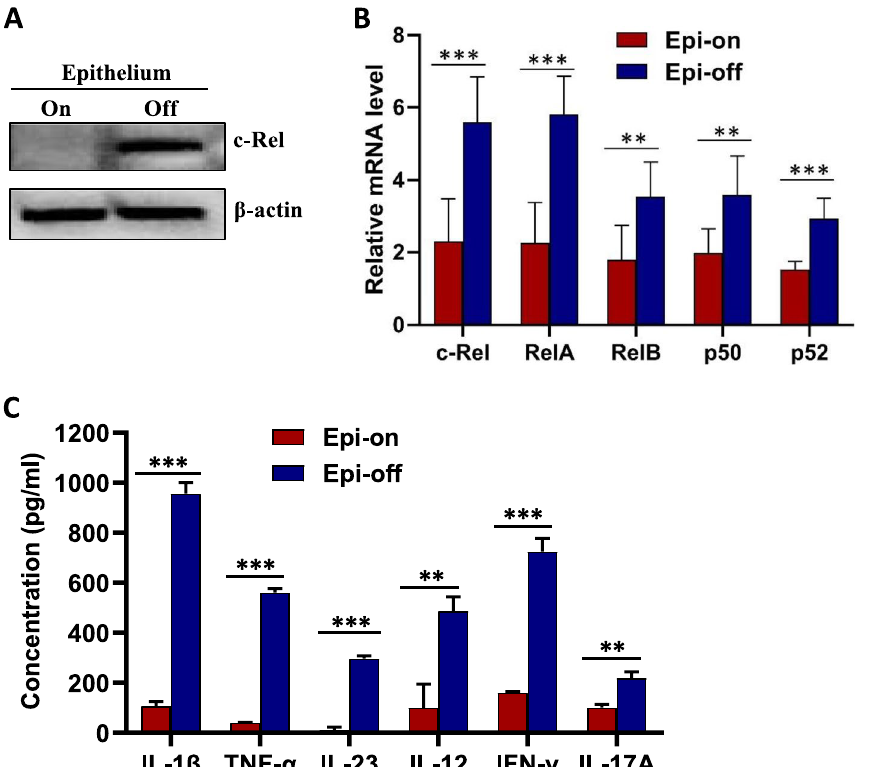
Fig. 1 Expressions of c-Rel and its inflammatory targets are increased in the cornea of mice with corneal injury. Mouse corneal epithelium was either untreated ( n 6) or scraped ( n 6) as described in the “Materials and methods” section. Corneas were isolated 24 h after epithelial scraping. = = A Total proteins were prepared from the corneas and c-Rel expression was determined by Western blot. β-actin was used as internal control. The blot was cropped to improve the clarity of the image and full-length blot was provided in the supplementary materials. B Total RNA was isolated from the cornea and mRNA expression of all five NF-κB family members was determined by quantitative RT-PCR. C Corneal tissue extracts were prepared and the production of inflammatory cytokines as indicated in the figure was determined by ELISA. Epi on: epithelium not scraped. Epi off: epithelium scraped off. Results shown are representative of two independent experiments. ** P <0.01, *** P